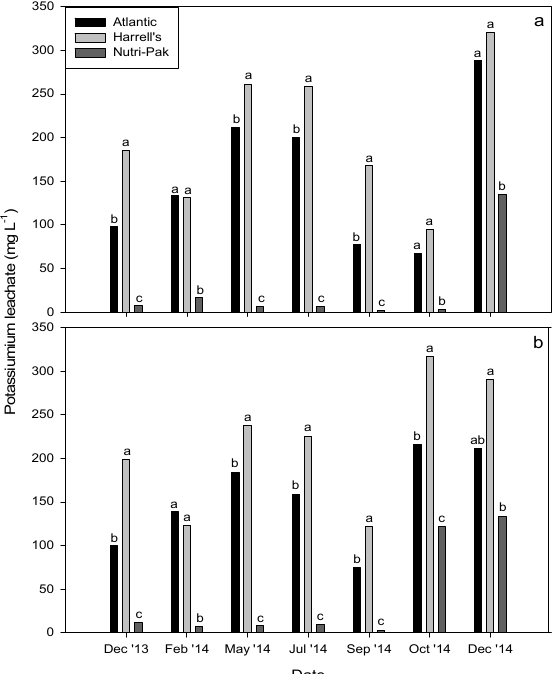
Figure 4. Potassium leached from potting medium Livistona chinensis ( a ) and Syagrus romanzoffiana ( b ) plants during 17 months of growth with Atlantic, Harrell’s or Nutri-Pak fertilizer. Letters above bars for an individual date represent mean separation by Tukey’s at 0.05